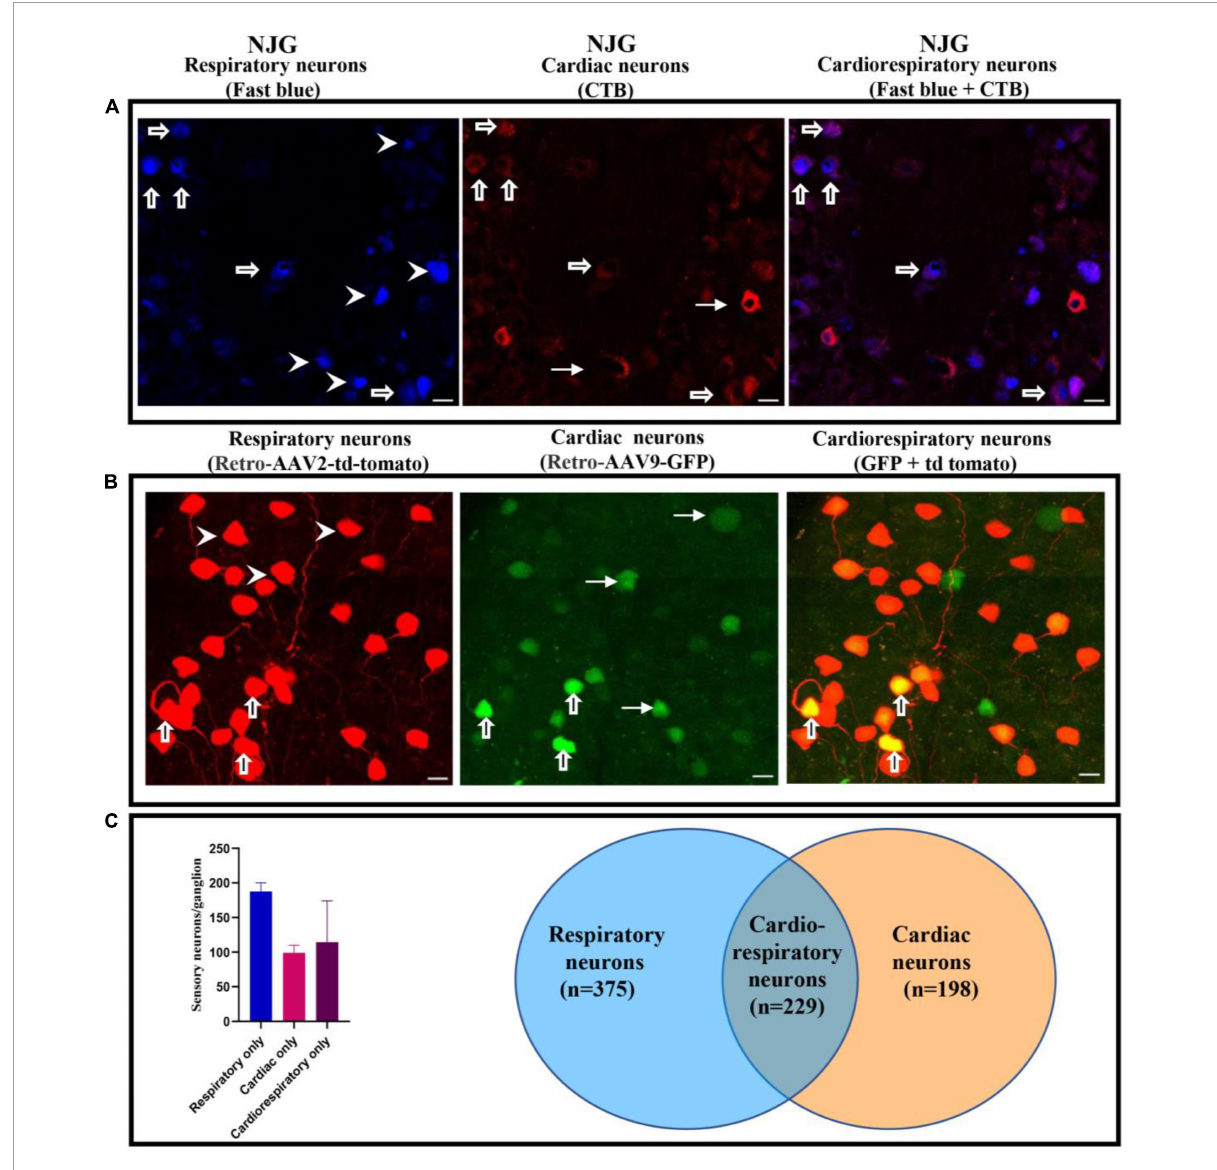
FIGURE1 Presence of cardiorespiratory neurons in the NJG. (A) NJGs were isolated from FB ( n = 6) and CTB administered mice ( n = 6), cryosectioned (7 um slices), and imaged using confocal microscopy. Presence of respiratory, cardiac, and cardiorespiratory neurons (dual labeling of CTB and FB) was observed in all ganglia (Bars = 20 µ m). Thick arrows point to cardiorespiratory neurons, arrowheads to respiratory only, and thin arrows to cardiac only neurons. (B) NJGs were isolated from retro-AAV2-td-tomato ( n = 5) and retro-AAV9-GFP ( n = 5) mice. Individual slices were imaged by confocal microscopy. Retro-AAV2-td-tomato and retro-AAV9-GFP also demonstrated evidence of neurons with dual labeling (Bars = 20 µ m). Thick arrows point to examples of convergent cardiorespiratory neurons, arrowheads to examples of respiratory only, and thin arrows to examples of cardiac only neurons. (C) Flow cytometry data from NJG (2 separate groups of 3–4 mice) also confirmed evidence of convergent